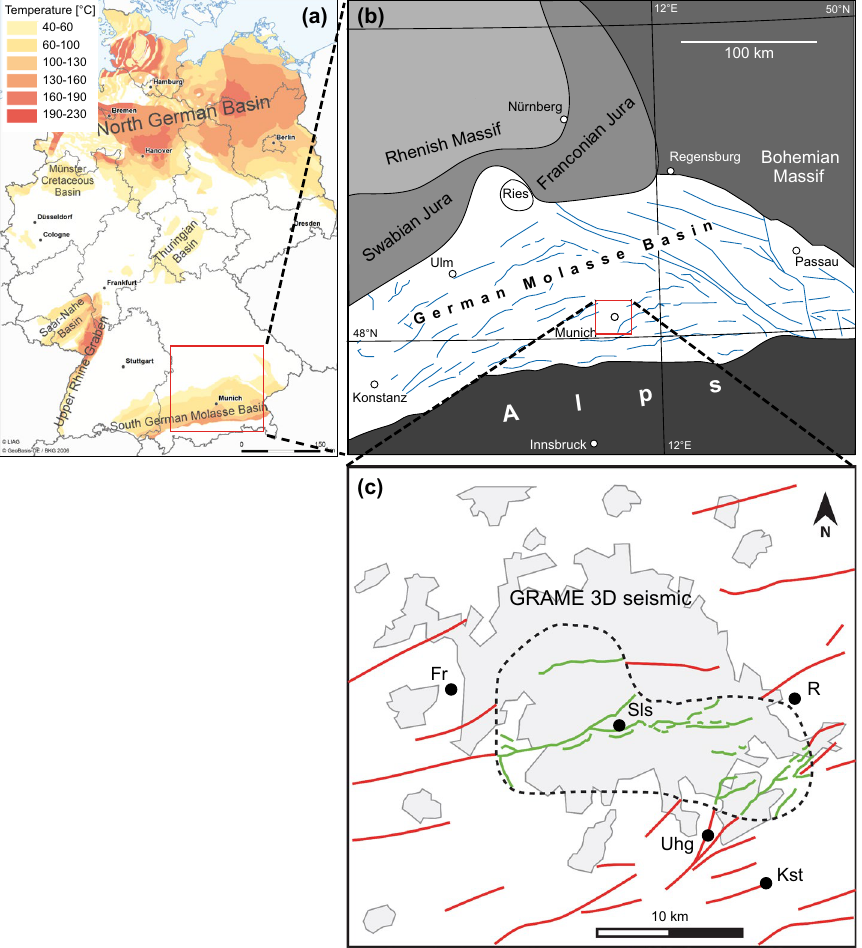
Fig. 1 The study area is located in the South German Molasse Basin ( a ; after Agemar et al., 2012) in the city of Munich ( b , c ). In 2016 a 170 km 2 3D seismic survey was conducted in Munich (outlined area with dashed line) to investigate and better understand the reservoir geometries and rock parameters. The colored lines are faults that result from strong tectonic deformation due to the Alpine orogeny (red: old known faults, green: newly identified faults from 3D seismic data interpreted by Ziesch (2019)). These might influence the reservoir and, therefore, geothermal production plants (Fr: Freiham, Kst: Kirchstockach, R: Riem, Sls: